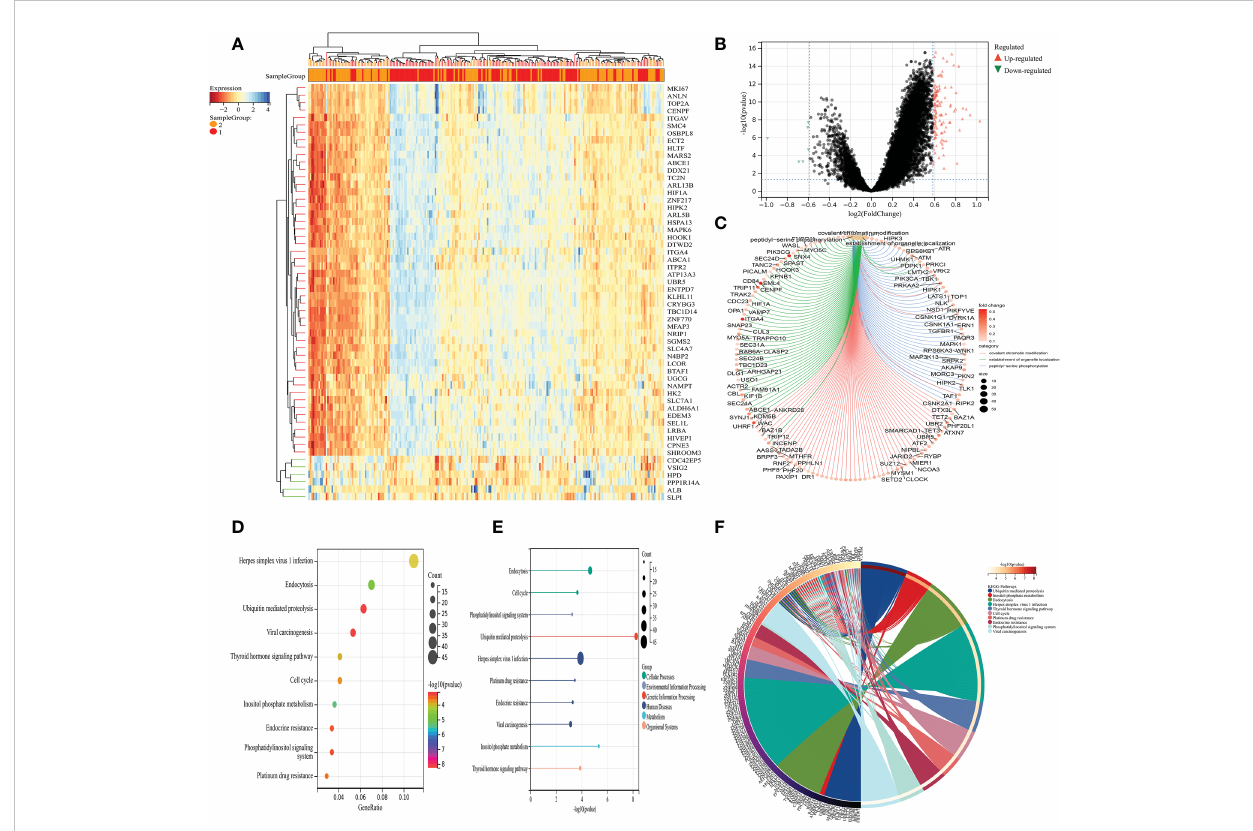
FIGURE 2 (A) The heat map demonstrated the differentially expressed genes between low- and high-CAFs groups; (B) The volcano map demonstrated the differentially expressed genes between low- and high-CAFs groups; (C) The GO enrichment analysis; (D-F) The KEGG enrichment